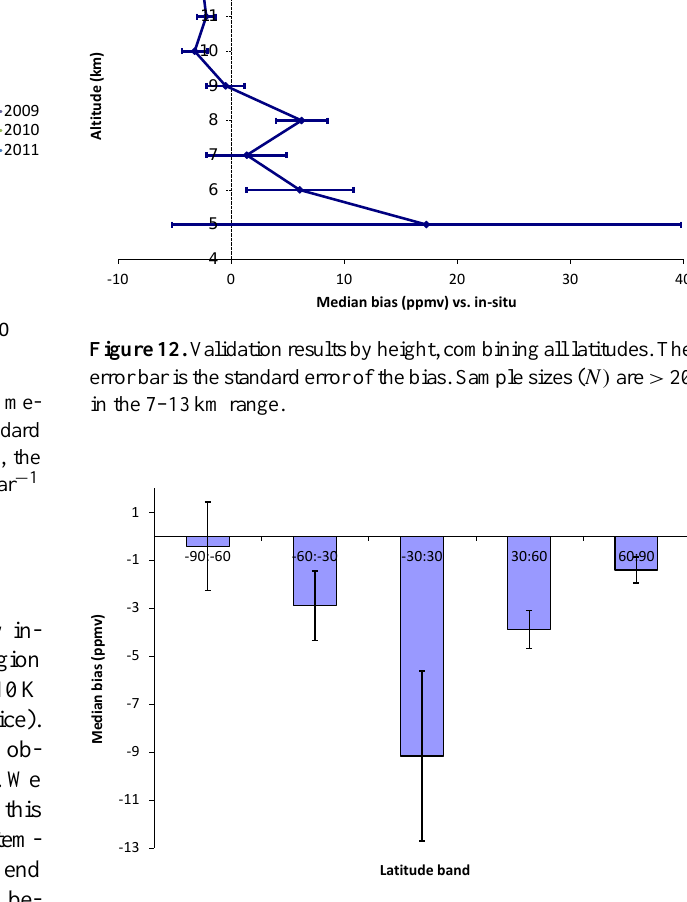
Figure 13. Validation by latitude band combining all heights be- low 13km. The error bar is the standard error of the ensemble of pairwise